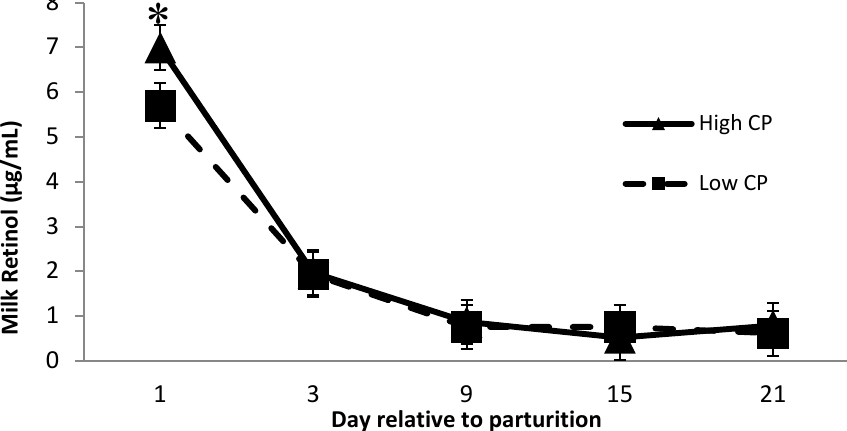
Figure 2. Milk retinol concentration the first 21 days of lactation for multiparous Holstein dairy cows ( n = 80, total) that were fed diets with crude protein levels (10.3%, n = 40 vs. 12.2% dry matter basis, n = 40) and within each crude protein group that was fed monensin (400 mg/day per head or none) and vitamin A (110 IU/kg body weight or none) during prepartum period (from day − 35 to the day of calving). All cows received a common lactation ration postpartum. Dietary crude protein × time interaction ( p = 0.04). Asterisks show significant difference at time point specified.